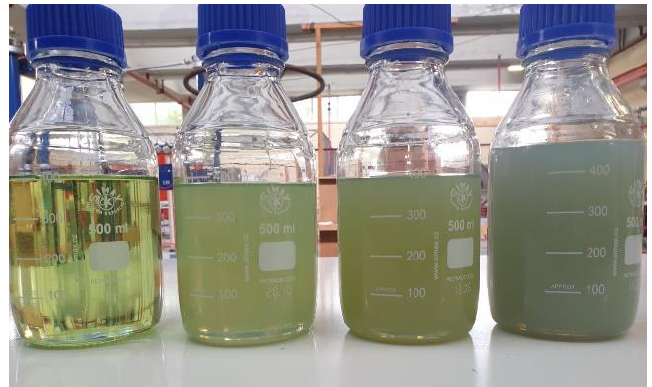
Figure 5. The samples immediately after their production, from left to right: Net, NF1, NF2 and NF3 samples.